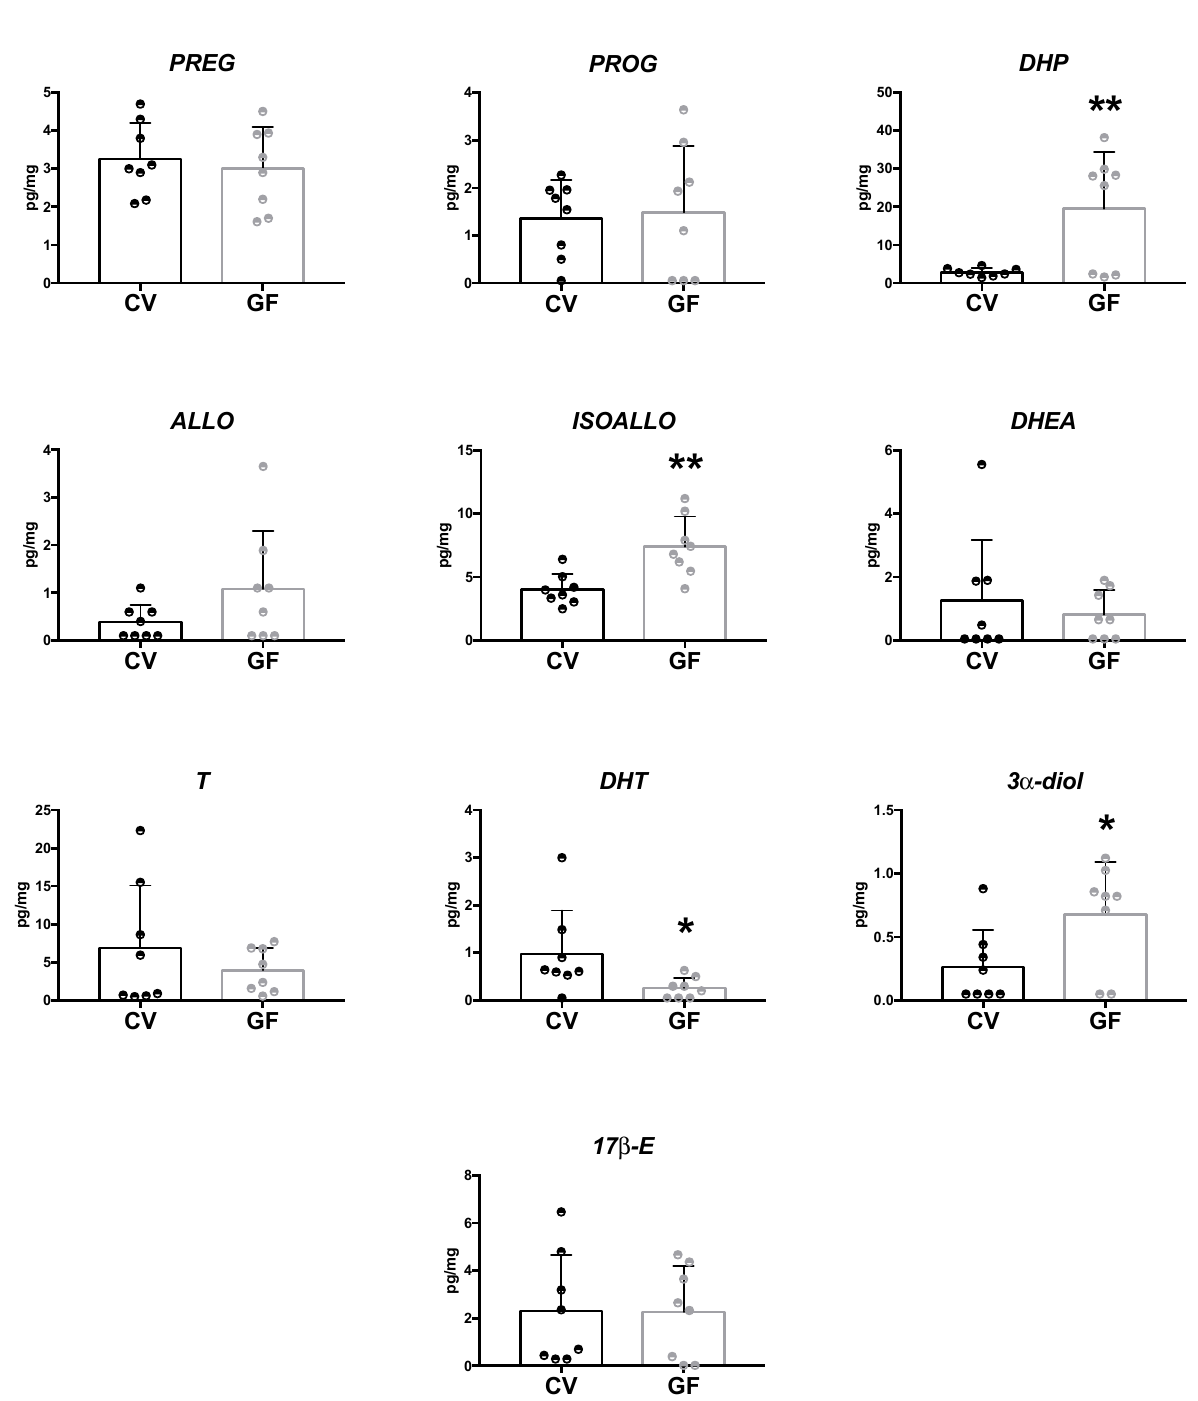
Figure 2. Levels of neuroactive steroids in the hippocampus of germ-free (GF) and conventional (CV) male mice. Data are expressed as pg/mg ± SD, n = 8 for each group. Unpaired student’s t -test analysis: * p < 0.05 ** p < 0.01 vs. CV mice.